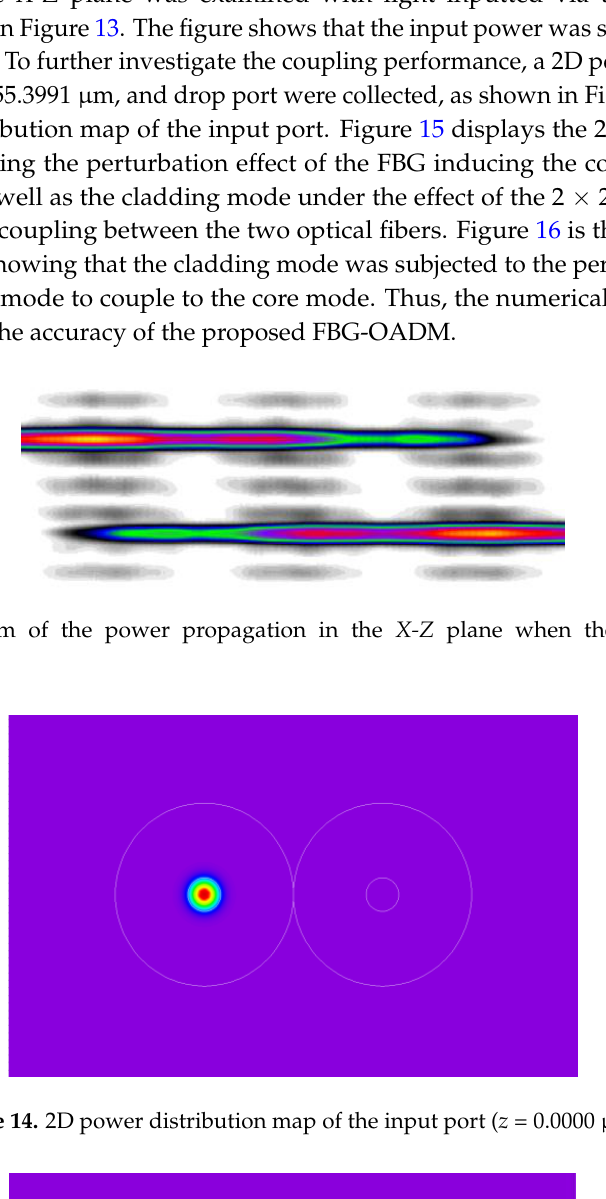
Figure 12. Diagram of the relationship between the transmission distance and power loss when the core mode was completely dropped.